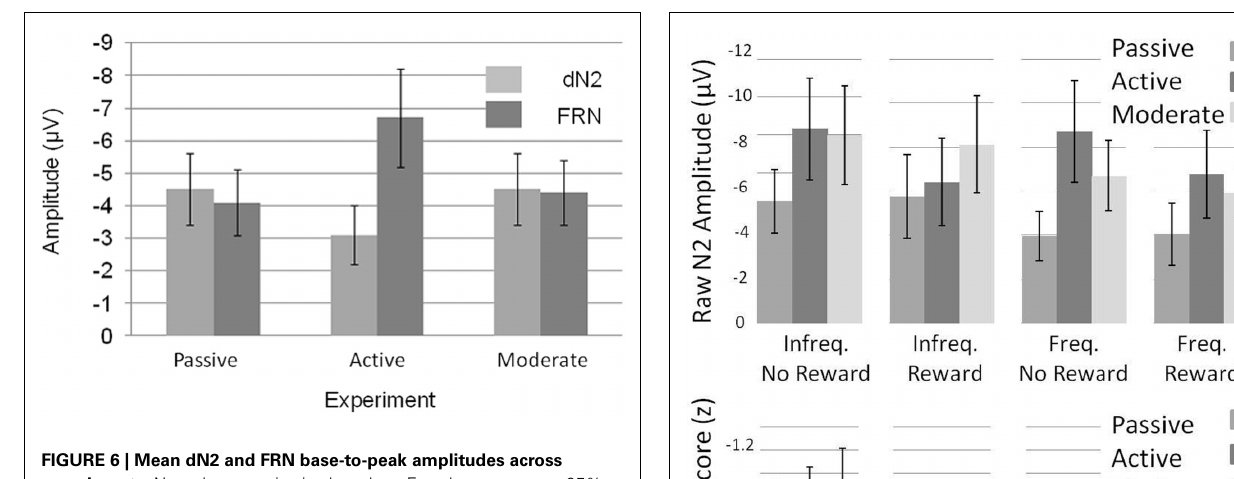
FIGURE 6 | Mean dN2 and FRN base-to-peak amplitudes across experiments. Note that negative is plotted up. Error bars represent 95% within subjects confidence intervals.